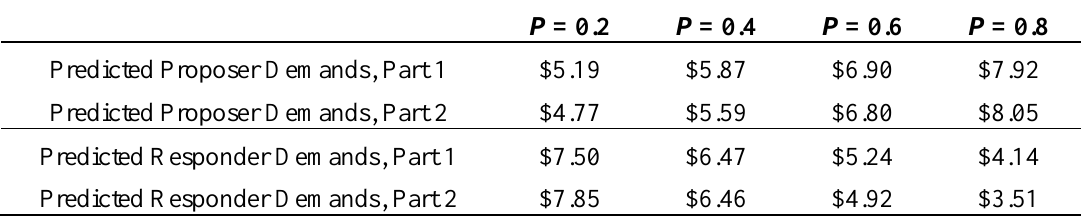
Table 6. Quantal Response Predictions for Proposer and Responder Demands Using Separate Precision Estimates for Part 1 (Rounds 1–5) and Part 2 (Rounds